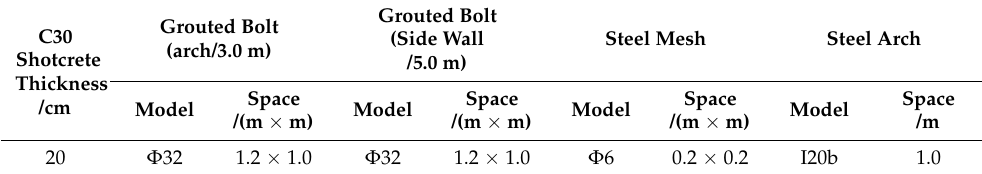
Table 2. Parameters of